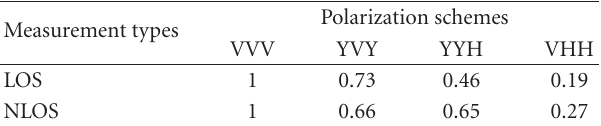
Table 6: Normalized power for di ff erent polarization schemes in indoor LOS environment. ⎛